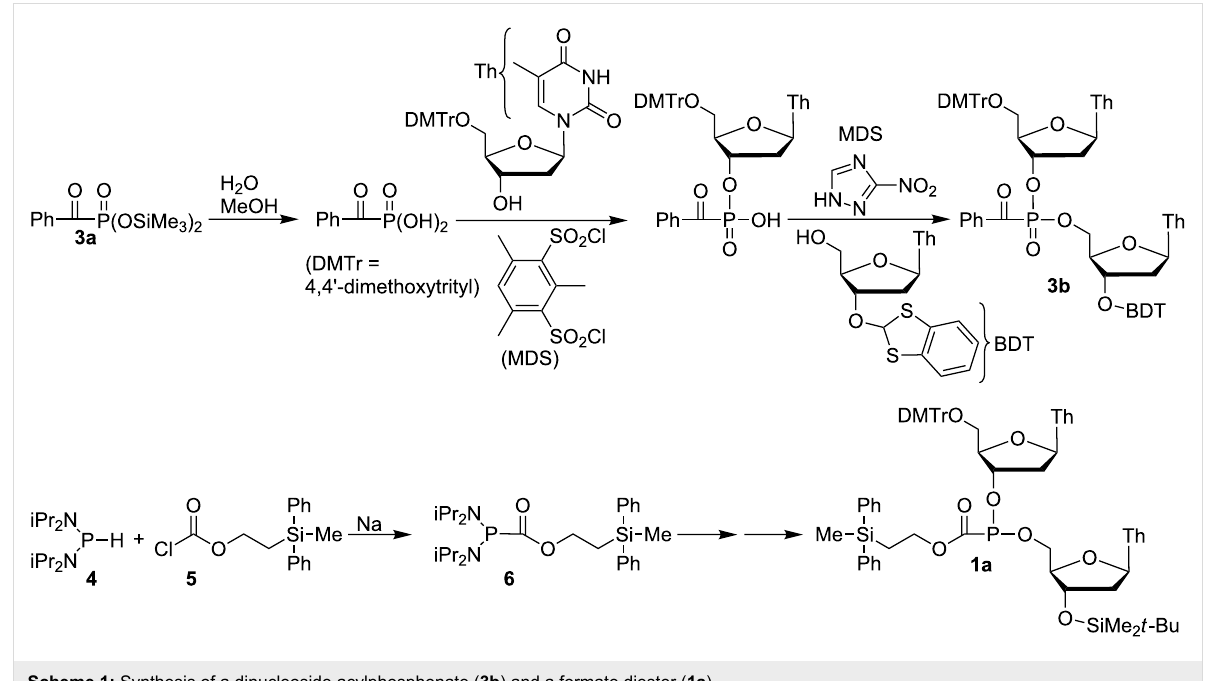
Scheme 1: Synthesis of a dinucleoside acylphosphonate ( 3b ) and a formate diester ( 1a ).